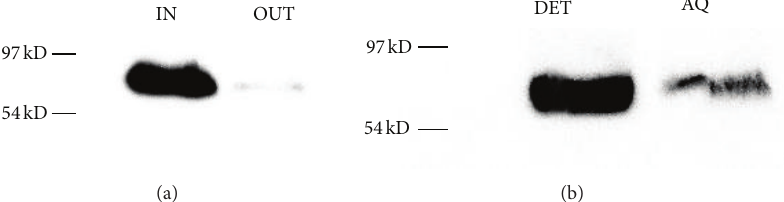
Figure 2: AtCslA2-GFP is insoluble in the detergent Triton X-114. Western blot analysis of protein fractions (intracellular, IN; incubation medium, OUT) obtained from AtCslA2-GFP transformed protoplasts (a). AtCslA2-GFP is Triton X-114 insoluble and is mainly recovered in the detergent phase (DET) a small contamination of the chimera was present in the aqueous phase (Aq) (b). Bands were detected using anti-GFP